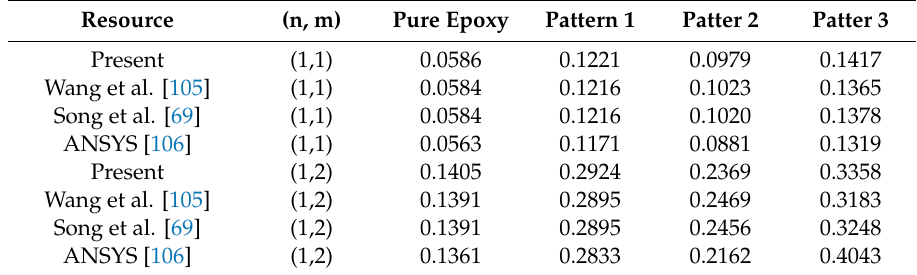
Table 3. Comparison of dimensionless fundamental frequencies of the GPLRC curved panel (a / b = 1, a / h = 10, R1 = R2 = ∞